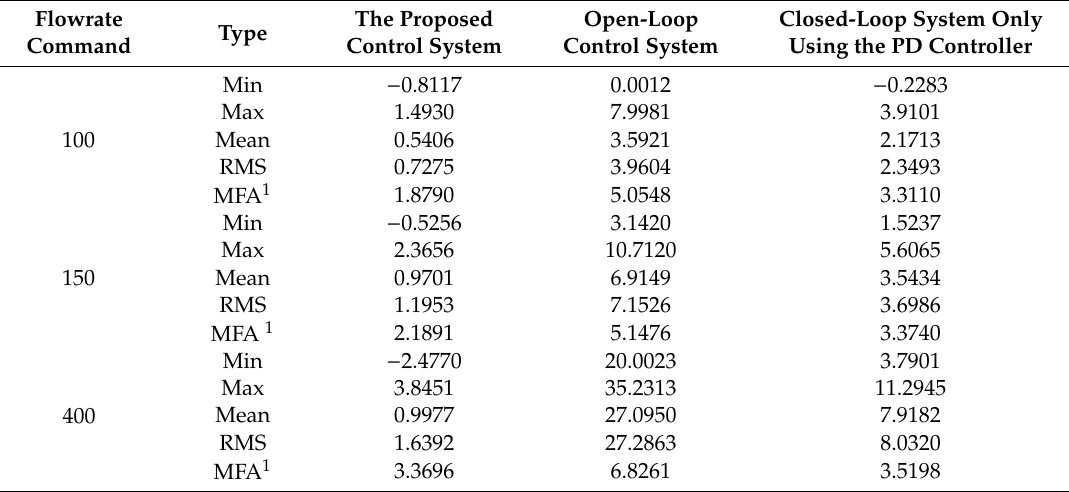
Figure 13. Comparison of experimental results with flow feedback at the steady state; ( a ) 100 cc / min flowrate command; ( b ) 150 cc / min flowrate command; ( c ) 400 cc / min flowrate command. Table 3. The experimental results of the steady-state feedback error.